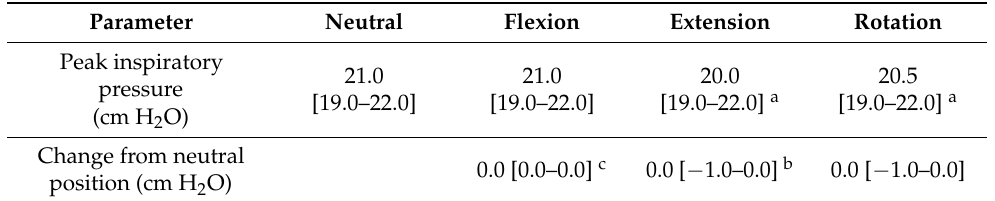
Table 4. Changes in peak inspiratory pressure with head positioning when the initial intracuff